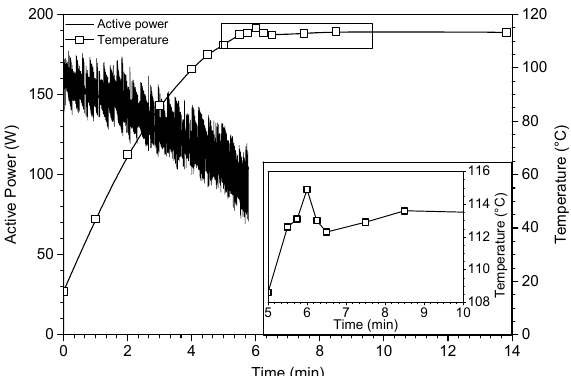
Figure 1. Monitoring conditions (ultrasonics power and temperature) of oligo-isosorbide glycidyl ether ultrasonic synthesis (Table 1, entry 5).